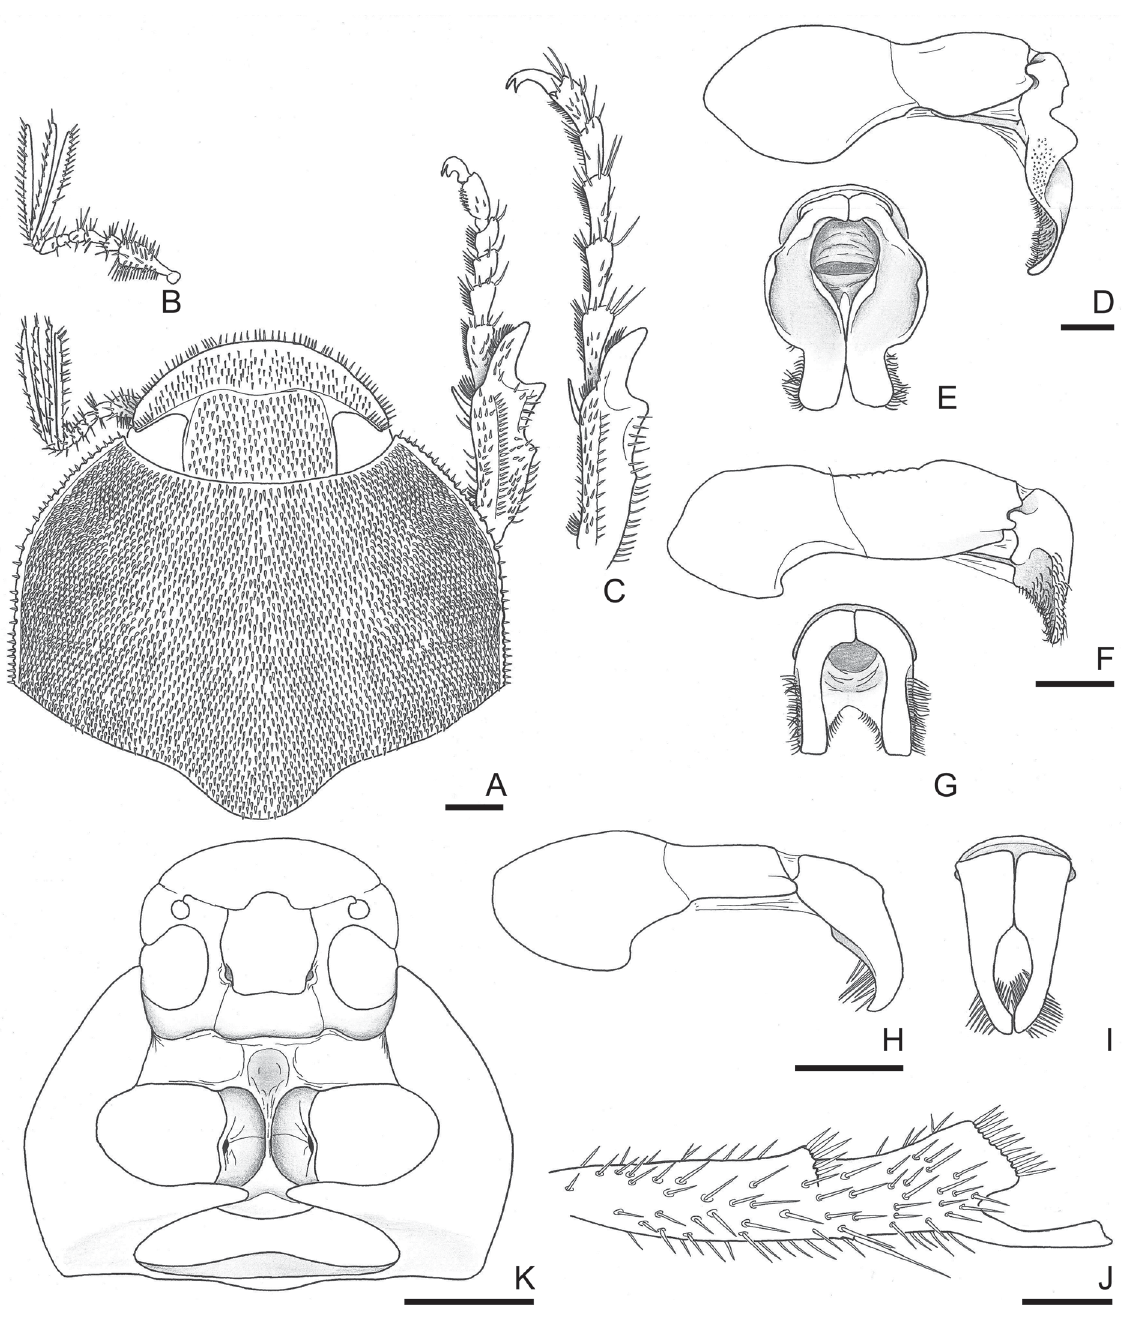
Fig. 12. ♂♂. A . Head–prothorax dorsal, tarsus rotated laterally to apex. B . Antenna. C . Protibia−tarsus. D−I . Aedeagus (lateral, parameres apex). J . Metatibia. K . Head−prothorax, ventral. A , F−G . Euryaspis obesa (Burmeister, 1855) comb. nov. B−E . Euryapsis gaudichaudi Blanchard, 1850. H−J . Philochloenia amata nom. nov. K . Philochloenia castaneipennis (Guérin-Méneville, 1831) comb. nov. Scale bars = 1